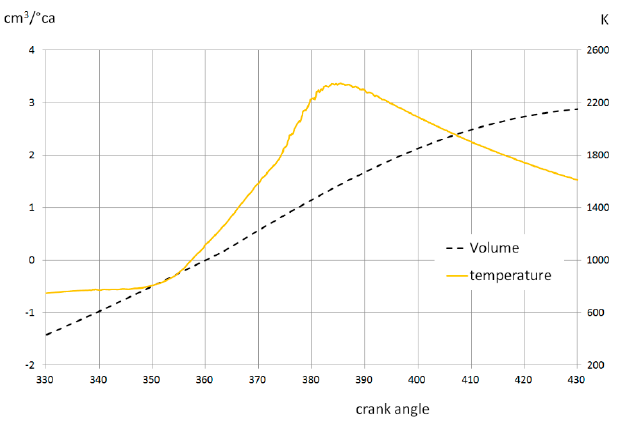
Figure 17. Temperature curve and volume changes (1500 rpm, 13 bar).